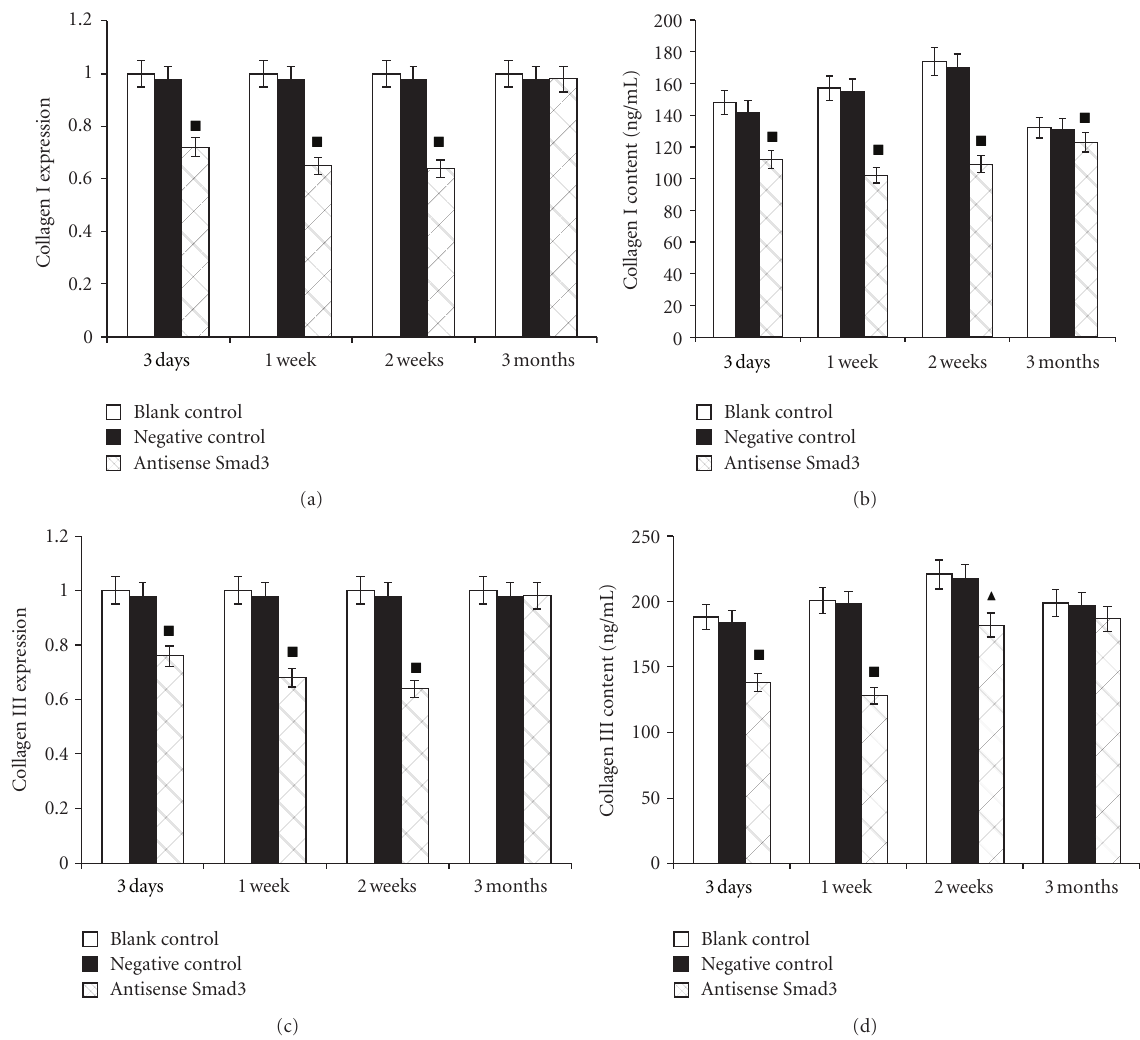
Figure 4: Expressions of type I and III collagen in VSMCs following injection of adenovirus expressing antisense Smad3 in vivo . Ninety SD rats were randomly assigned into blank control group, experiment group, and negative control group. In all groups ( n = 5 per group), rats were sacrificed at 1 day, 3 days, 1 week, 2 weeks, 1 month, and 3 months after injury followed by sample collection. Total RNA was extracted for the detection of mRNA expressions of type I and III collagen with quantitative PCR (a, c). In addition, the serum was also collected from rats followed by detection of type I and III collagen contents with ELISA (b, d). (a) mRNA expression of type I collagen in di ff erent groups; (b) content of type I collagen in the serum of di ff erent groups; (c) mRNA expression of type III collagen in di ff erent groups; (d) content of type III collagen in the serum of di ff erent groups. The mRNA expressions of type I and III collagen were normalized to that of β -actin. The mRNA expressions of type I and III collagen in the blank control group served as the baseline levels, and those in other groups were normalized to those in the blank control group as the fold change which was used for delineation. Data were expressed as mean ± SD. (cid:2) P < 0 . 05, (cid:3) P < 0 . 01 versus negative control